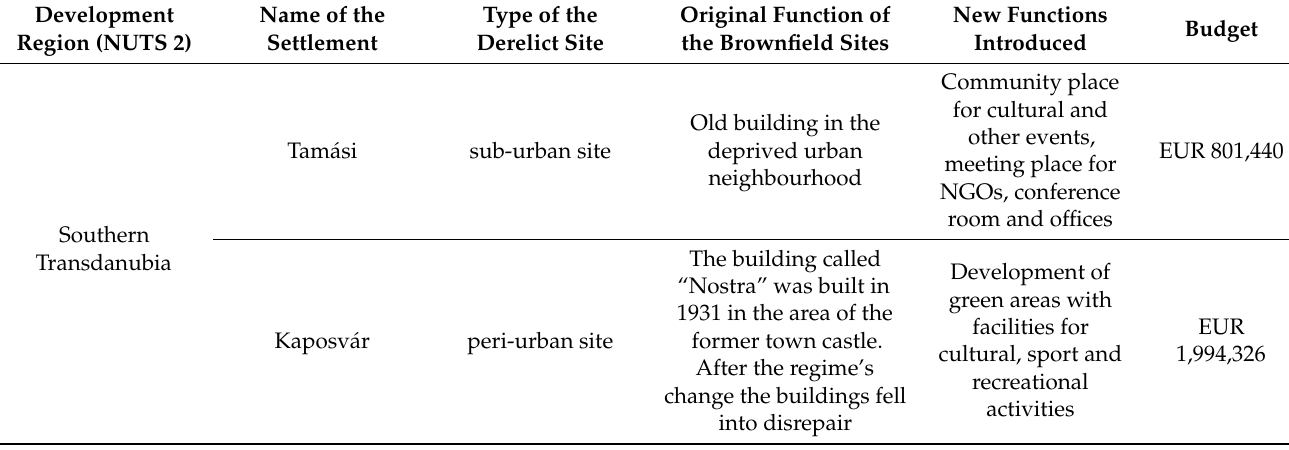
Table 3. Redevelopment projects for diverse derelict